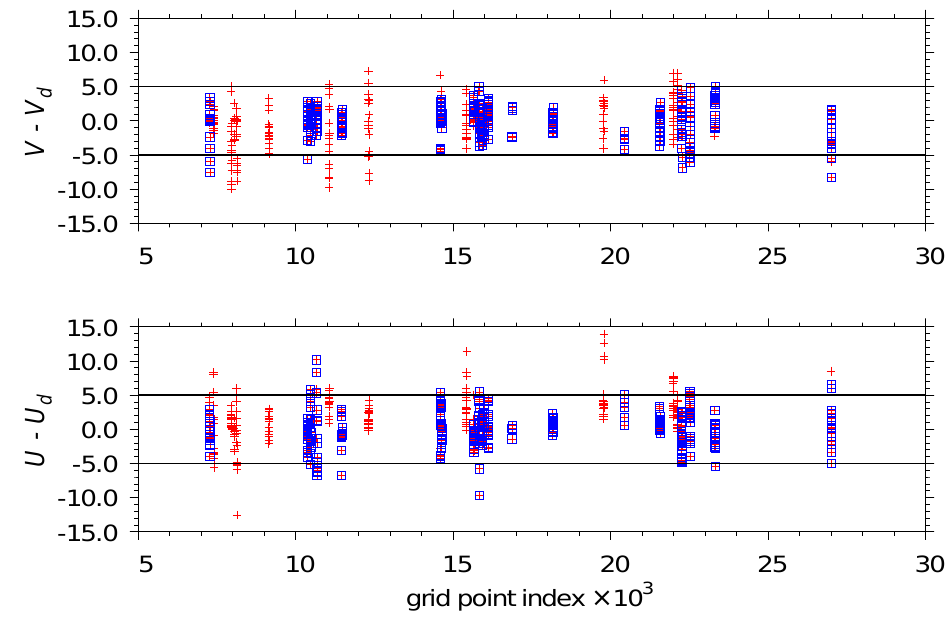
Fig. 15. The upper panel shows the difference between the meridional component of the retrieved velocity (using radar data only) and the gridded sounding data. Red marks show this difference for all grid points where there are dropsonde observations, while blue boxes show which of those grid points have radar observations that constrained the retrieved velocity. The horizontal axis is just the grid point index obtained by traversing the grid in C-style order(the last index varying the fastest) The lower panel shows the same, but for the zonal component of the